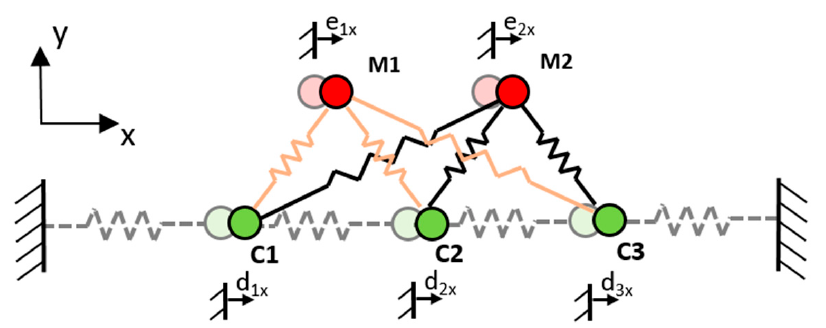
Figure 3. Scheme of a 1-dimensional task (x-direction) with 2 measured points (M1, M2) and 3 nodes (C1, C2, C3).